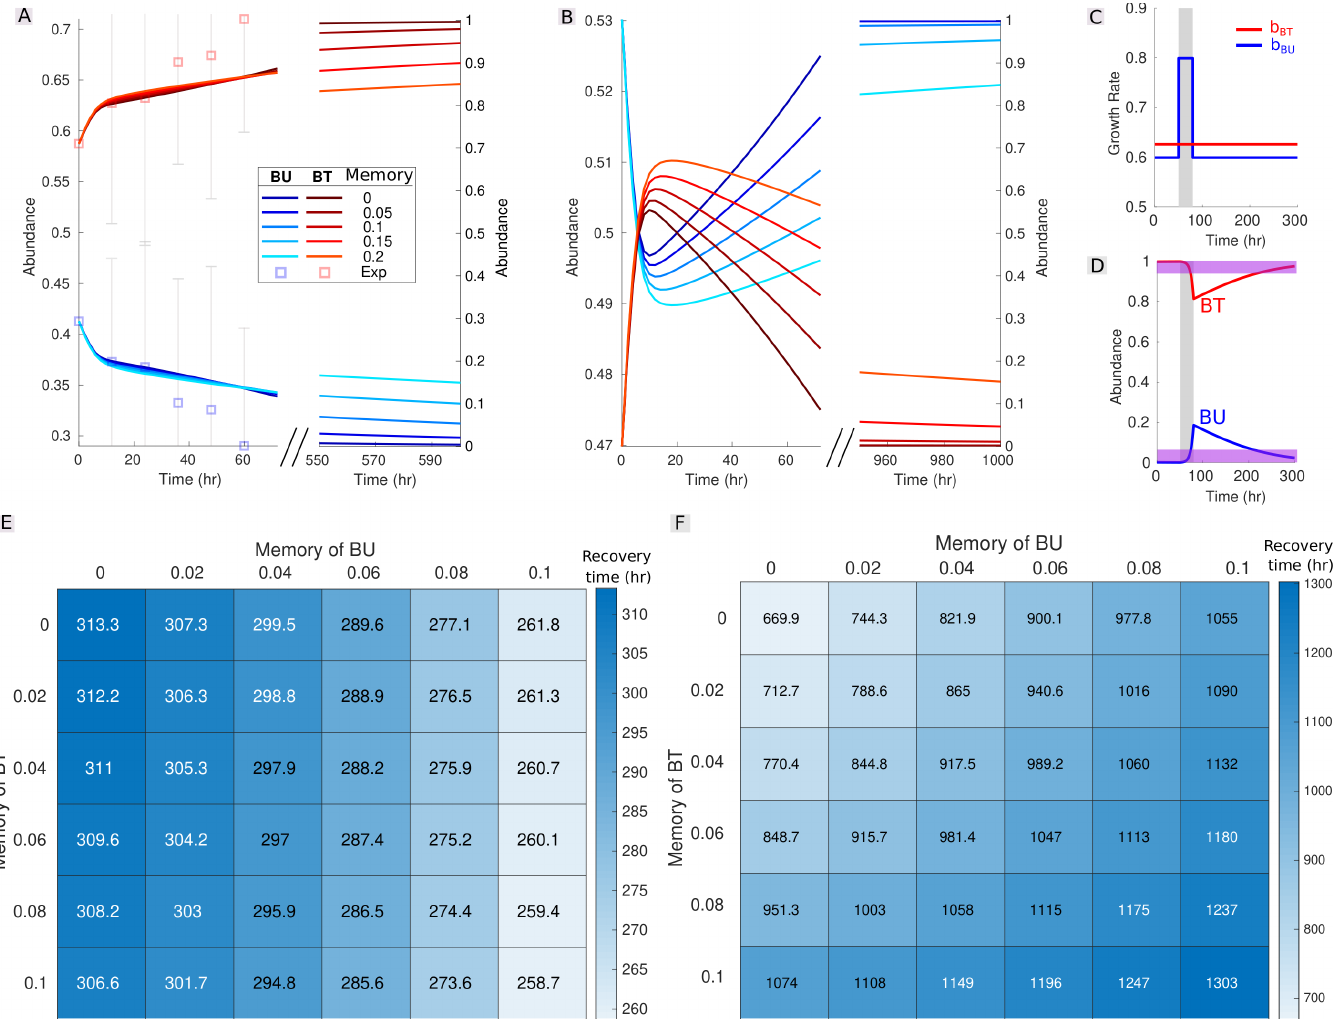
Fig 7. Impact of memory on the dynamics of an empirically parameterized bistable community. (A-B) Dynamics of a bistable community composed of Bacteroides uniformis (BU) and Bacteroides thetaiotaomicron (BT), as simulated from a gLV model fitted to a set of empirical time series by Venturelli et al. [39] in which we have introduced memory effects (Eq (2) in the Methods). (A) Dynamics for the same initial conditions as one of the empirical time series used to fit the model. The original empirical data are indicated by squares and (truncated) error bars centered on the squares, representing the mean and standard deviation across biological replicates, respectively. (B) Dynamics for initial conditions leading to the alternative stable state dominated by BU. (A) and (B) illustrate that increasing memory lengthens the convergence time to the stable state, although it may hasten it in initial stages. (C-D) For each matrix entry in (E-F), a pulse perturbation is applied to the growth rate of BU (C), which temporarily displaces the community away from its original stable state dominated by BT (D). Convergence is achieved once species abundances reach an arbitrarily set convergence interval (in purple). (E-F) Recovery time to stable state after perturbation as a function of memory strength in BU and BT (the upper-left cell corresponds to the memoryless case). Both color and matrix entries indicate the recovery time after a pulse perturbation starting from the BT-dominated stable state, as illustrated in (C-D). (E) Recovery times are measured using a loose convergence interval (Bray-Curtis dissimilarity of 0.02 or lower between the community’s current state and its initial stable state), thus capturing the early stages of the recovery. Recovery time decreases with increasing memory, i.e., memory effects increase resilience. (F) Recovery times are now measured using a much tighter convergence interval (Bray-Curtis dissimilarity of 7 e − 4 or lower), thus capturing the later stages of the recovery. Recovery time now decreases with increasing memory, i.e., memory effects decrease resilience. Hence, as for the two-species Gonze model in S8 Fig, the effect of memory on resilience depends on the time scale considered: memory hastens the recovery at first (E) but slows it down further in time (F).